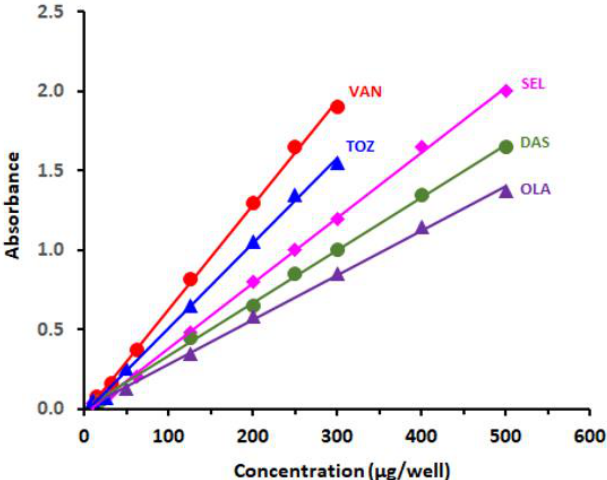
Figure 8. Calibration curves for determination of TKIs by the proposed 96-microwell-based spec- trophotometric assay based on their reaction with CLA. Measurements were carried out at 490 nm.